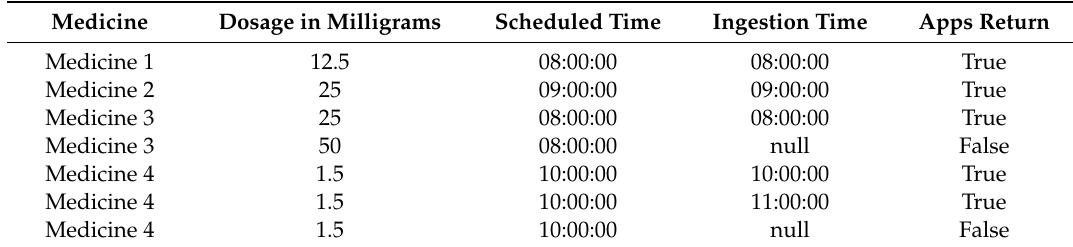
Table 3. Sample from electronic prescription